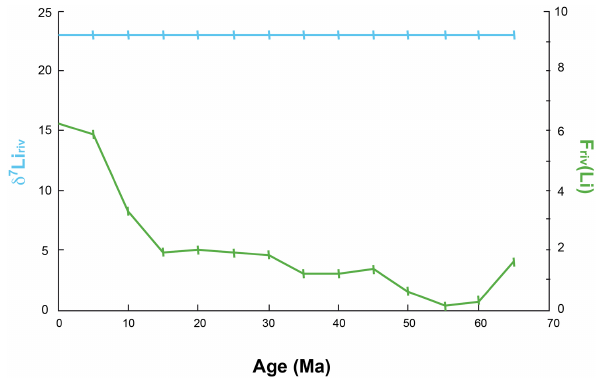
Figure 2. Simulation assuming constant δ 7 Li riv (in blue) as a func- tion of time. As shown here, the seawater δ 7 Li record presented in Fig. 1 can still be fitted if the flux of river Li ( F riv in 10 9 molyr − 1 , in green) increased significantly during the same period of time. This example demonstrates the lack of constraints on the steady- state model if only the equation for Li is considered. In addition, this example shows that river δ 7 Li can display temporal variations that are significantly different from the ocean δ 7 Li